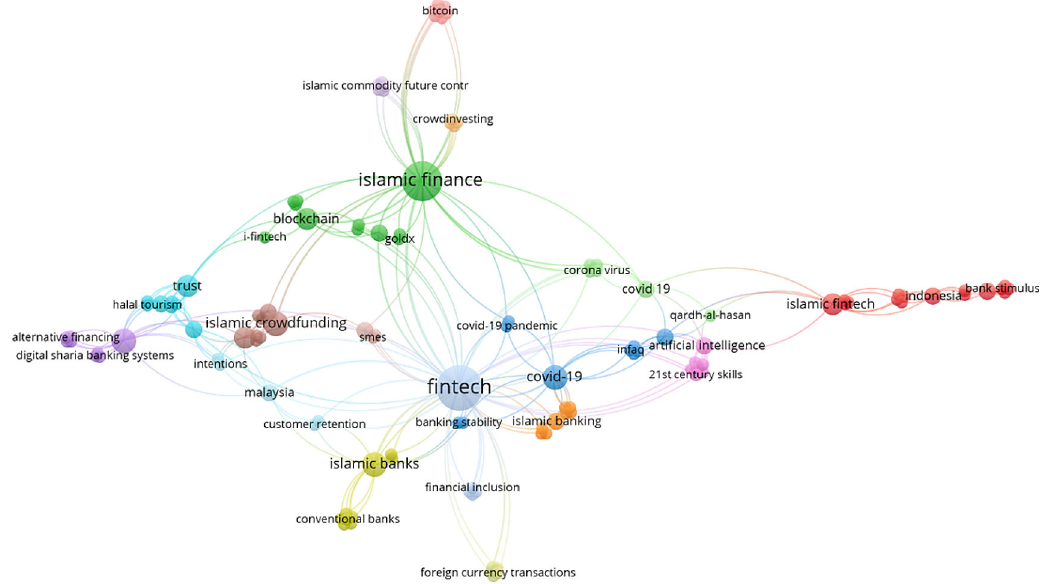
Figure 4. Co-occurrence network of authors